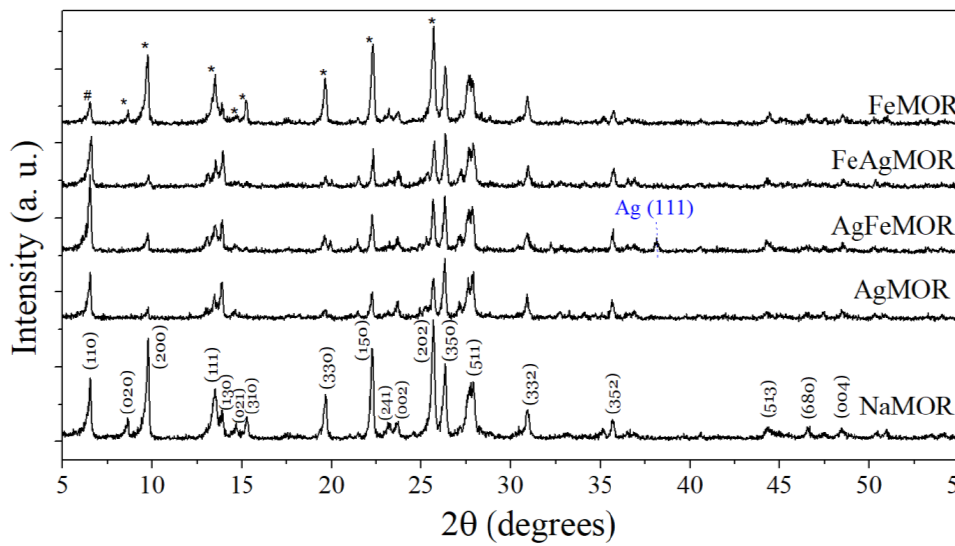
Figure 1. XRD patterns of the studied samples. Diffraction lines with different relative peak intensities, corresponding to mordenite, for samples of the source material; after the exchange of Na + for Fe 2+ or Ag + are marked with the symbols “#” and “*”, respectively.